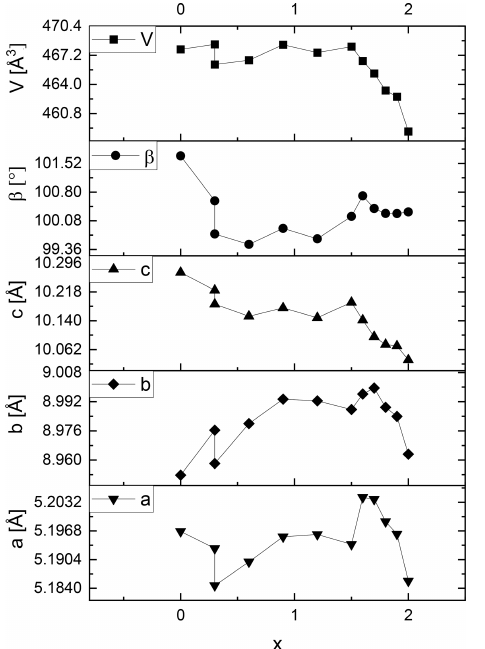
Figure 5. Lattice metric of the polytype 1M of selected lepidolite and Li-muscovite samples adapted from Table S1. The error mar- gins are less than the width of the data symbols.